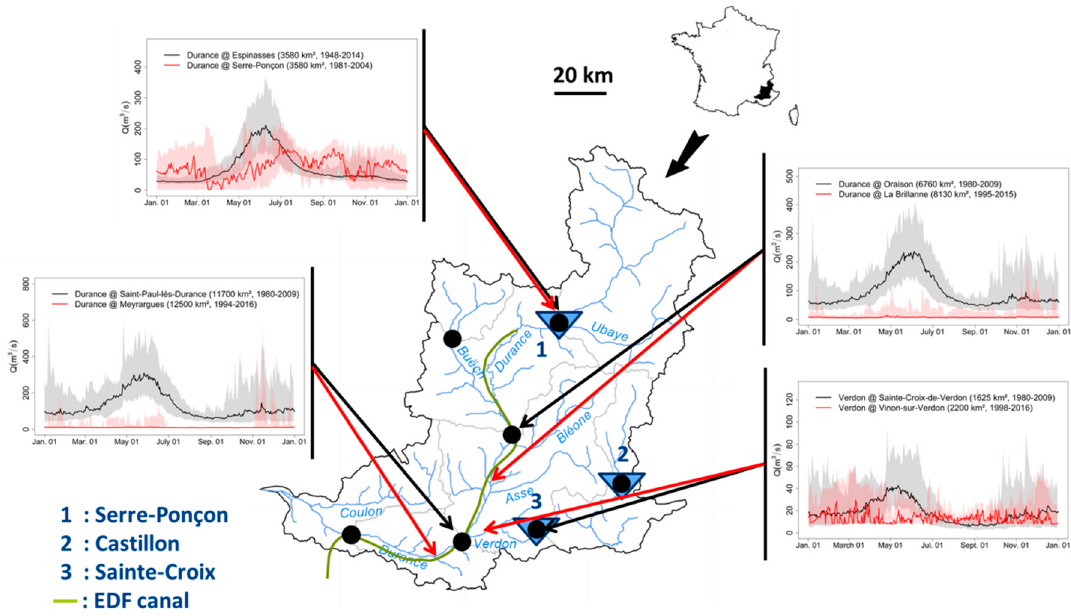
Figure 1. Comparison of natural (black) and observed (red) median annual hydrographs at different locations within the Durance River basin. Shading indicates the interdecile range of the daily river flow. Triangles indicate the location of the main reservoirs. Black dots are the locations of the sub ‐ basins examined within the “Risk, Water Resources and Sustainable Development within the Durance River Basin in 2050” (R 2 D 2 ‐ 2050) project.